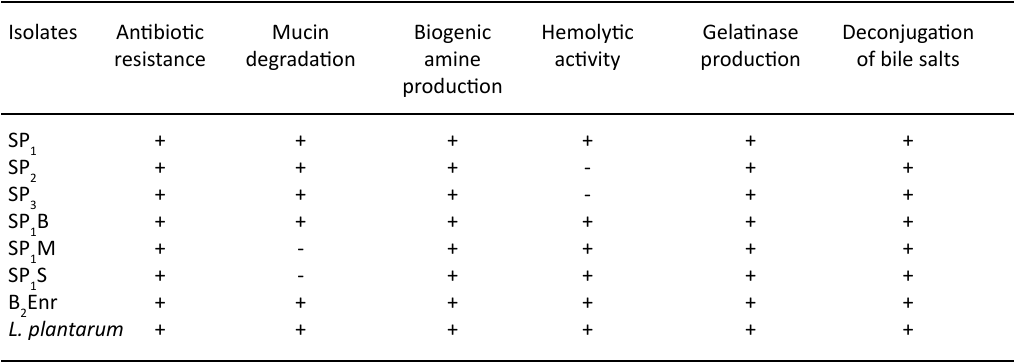
(b) Comparison of in vitro biosafety